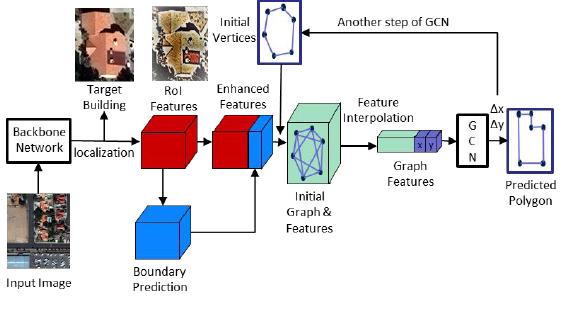
Figure 4.1: Network Diagram of